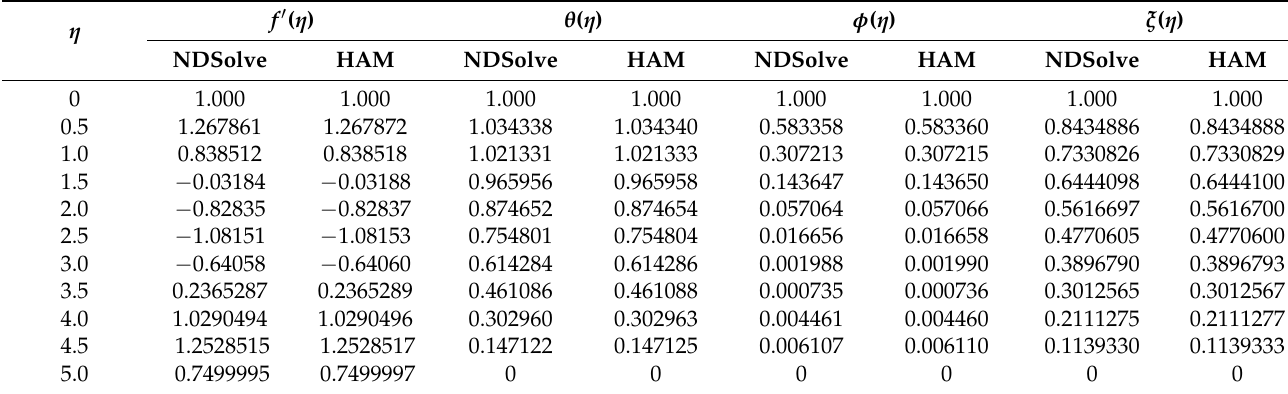
Table 7. A comparison between ND solves and HAM